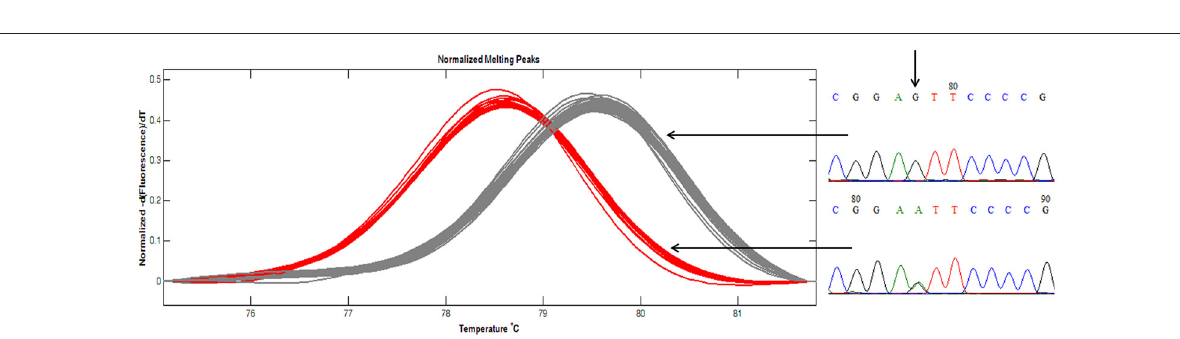
in peanut, which ranged between 0.080 and 0.478 with a mean of